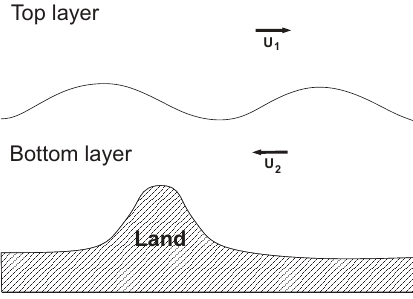
Figure 1. Geometrical layout of the two-layer quasi-geostrophic Figure 1: Geometrical layout of the two-layer quasi-geostrophic model.